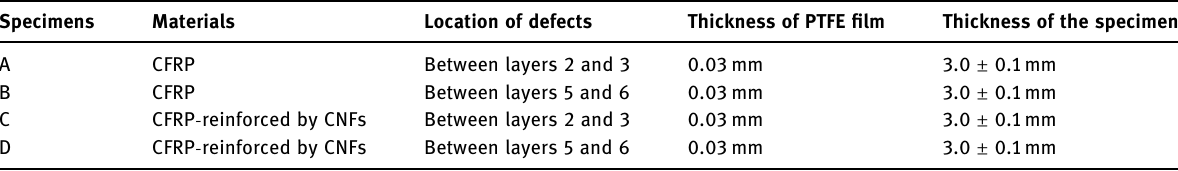
Table 1: Detailed feature description of the